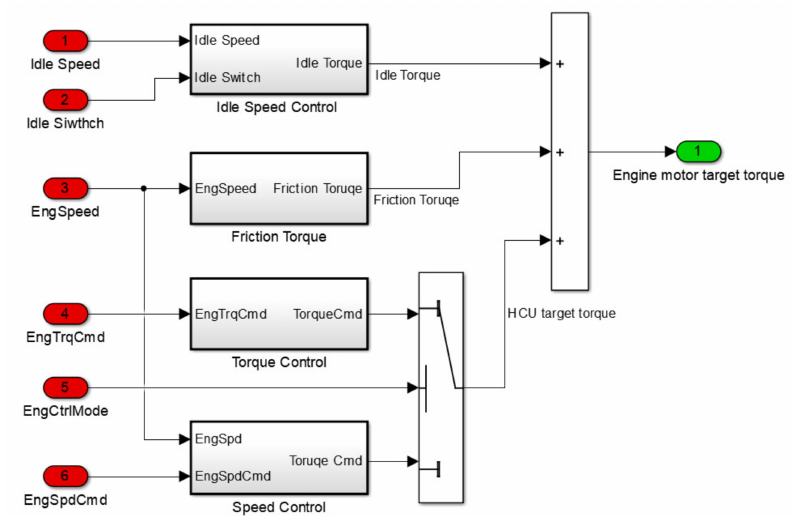
Figure 15. Engine model developed based on MATLAB /